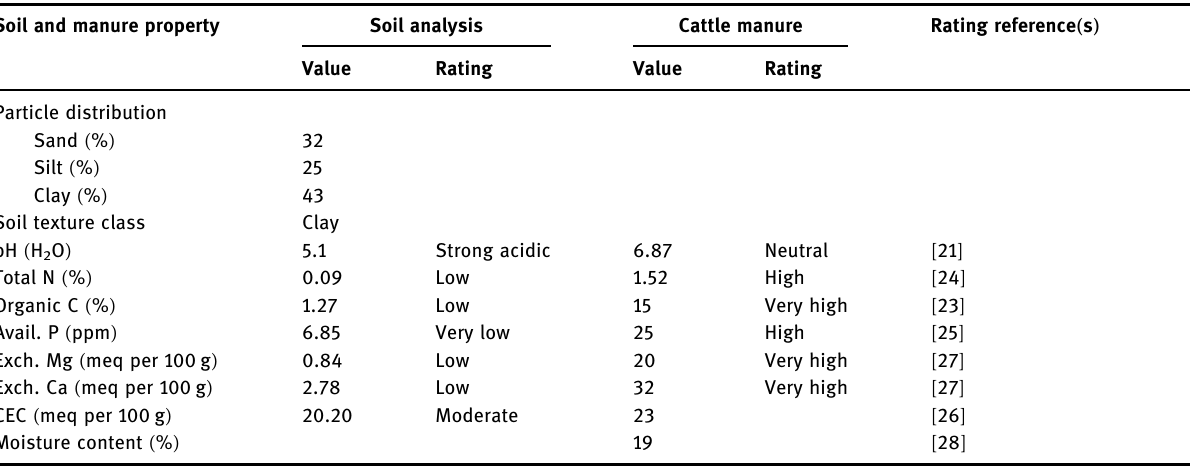
Table 1: Some important physico - chemical properties of the experimental soils before plowing and composition of cattle manure used for the experiment Soil and manure